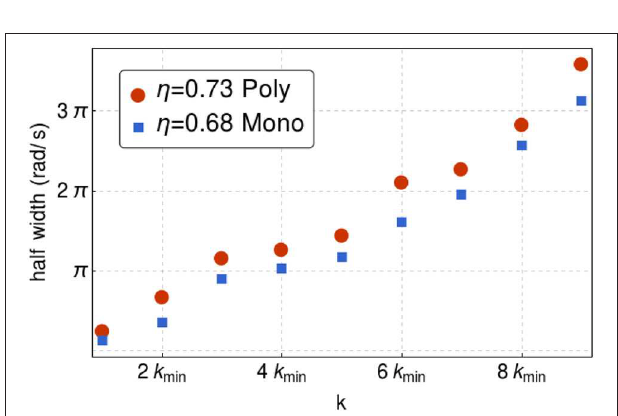
FIGURE 4 | Plot of the dynamical gap vs reduced packing fraction (1η/η c ) α . The data points correspond to the simulations while the dashed lines corresponds to fits (see legends). The computations were made for systems with N 2,500 disks. =